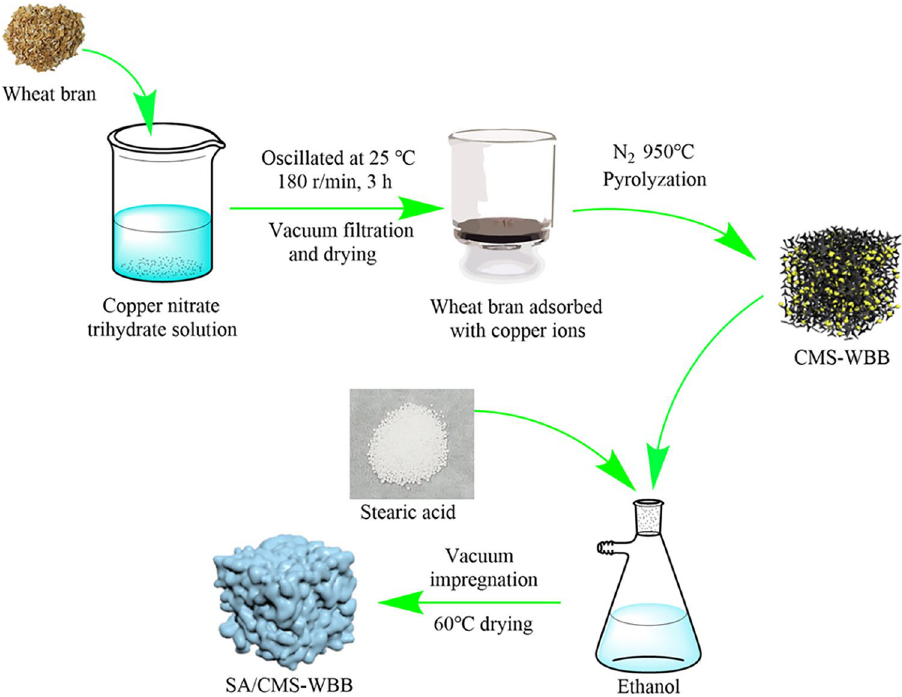
Figure 1. Schematic diagram of SA/CMS-WBB